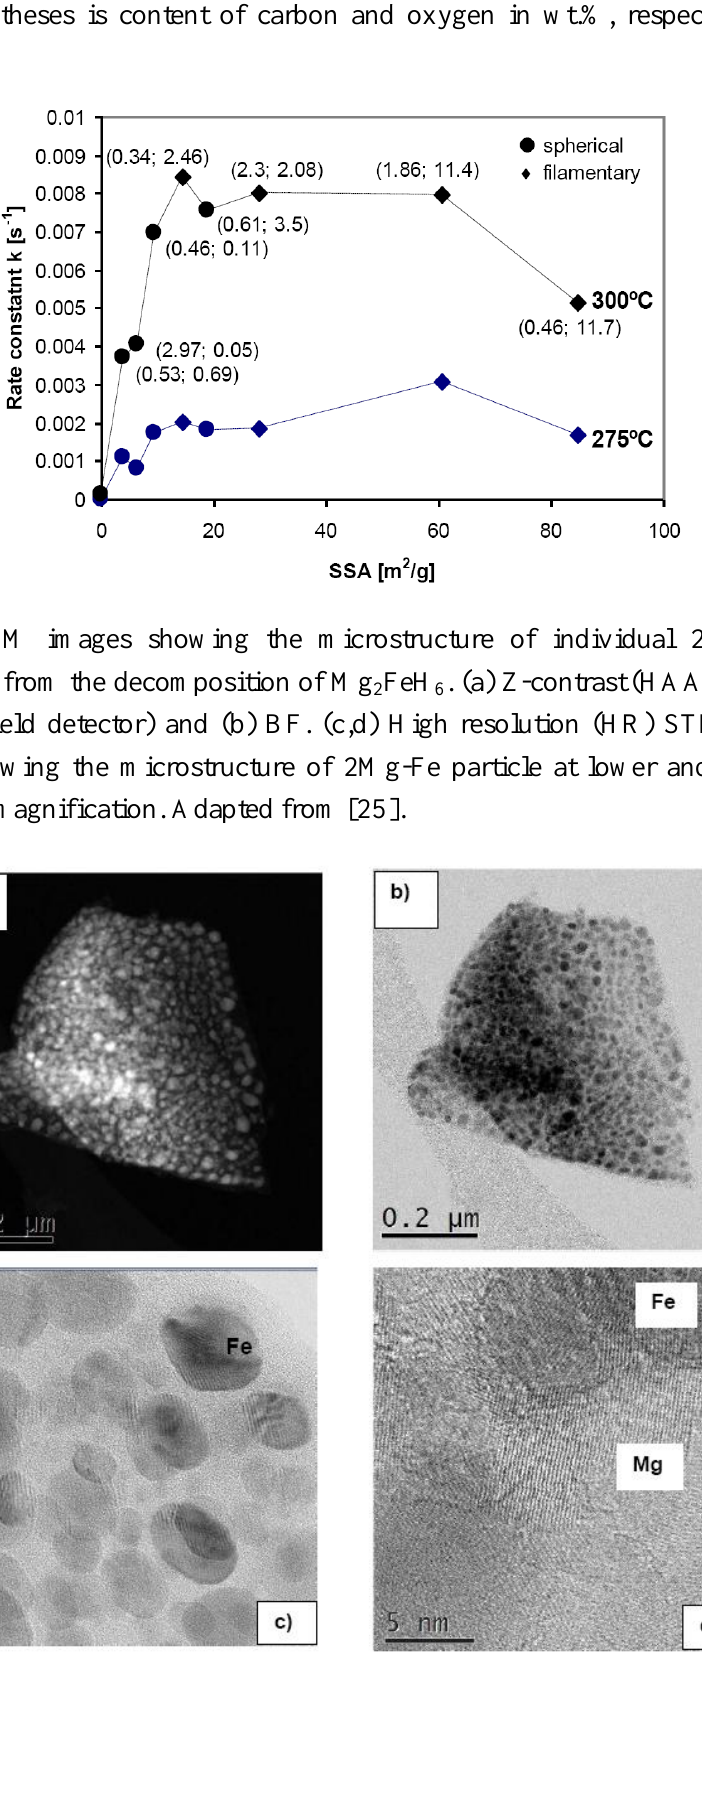
Figure 9. The rate constant, k , in the Johnson-Mehl-Avrami-Kolmogorov (JMAK) equation as a function of the SSA of the Inco n-Ni catalytic additive. The first and second number in parentheses is content of carbon and oxygen in wt.%, respectively. Adapted from [2].